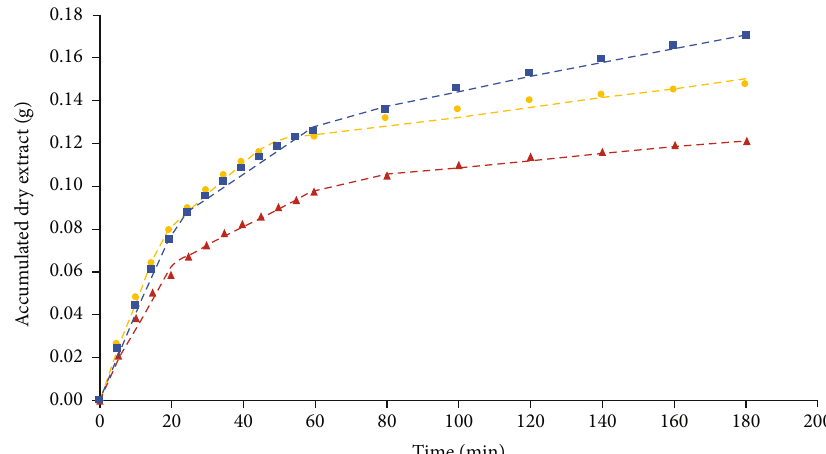
Figure 4: Spline mathematical model fi tted to the experimental data of epicarp (circle), seed (square), and seed tegument (triangle). The line “ dot, dot, dot ” is the model fi tted to epicarp, “ dash, dot, dash ” for seed, and “ dash, dash, dash ” for seed